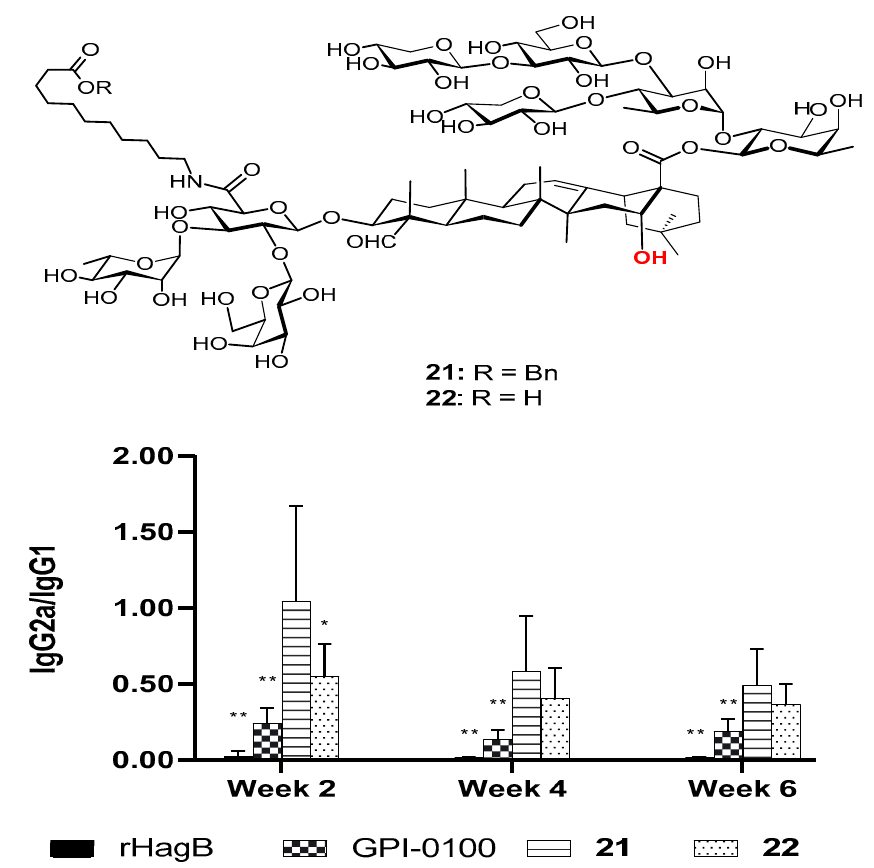
Figure 8. Semi-synthetic MS derivative VSA-2. Mice were immunized by the s.c. route with rHagB alone or with GPI-0100 or a saponin adjuvant on days 0, 14, and 28. Serum samples were collected prior to each immunization and at 6 weeks after the initial immunization. IgG2a/IgG1. Values are expressed as mean ± SD. Statistical significance compared with rHagB + VSA-2 ( 21 ). Statistical significance was evaluated by t tests (with unpaired, nonparametric, and Mann − Whitney test). * p < 0.05; ** p < 0.01.